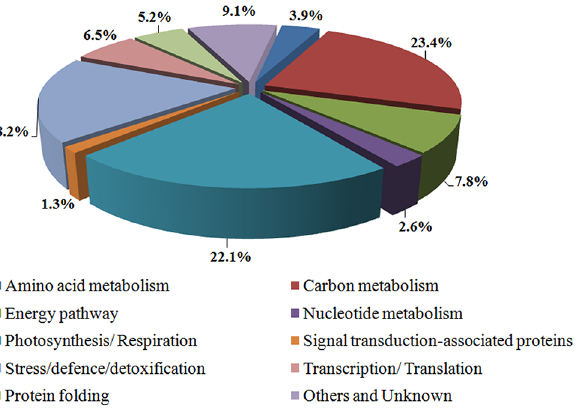
Fig 3. Functional distribution of identified differentially accumulated proteins in CS and